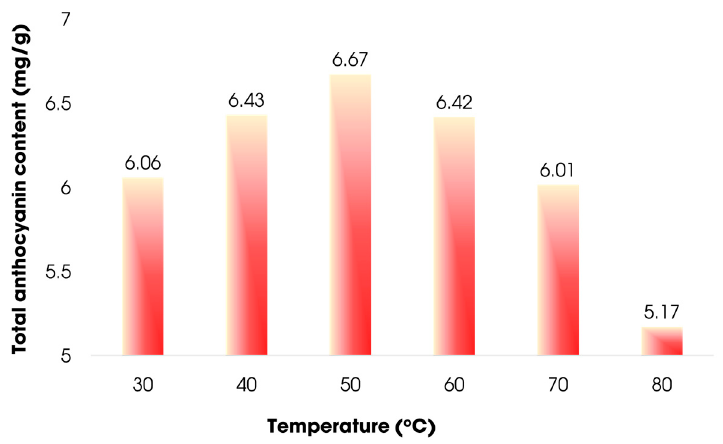
Figure 4. Extraction yields under different temperatures.